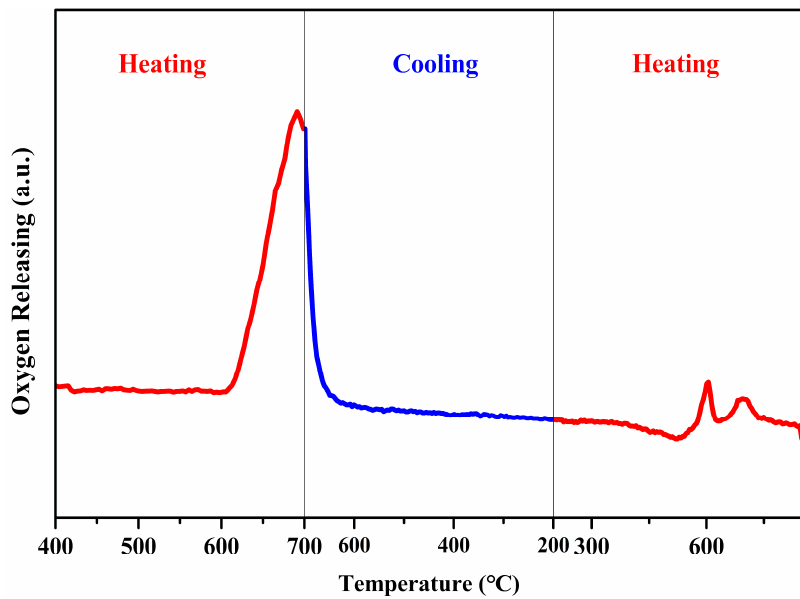
Figure 6. O 2 temperature programmed desorption (O 2 -TPD) cyclic desorption profiles of the PdAg/Z- 500 catalyst.